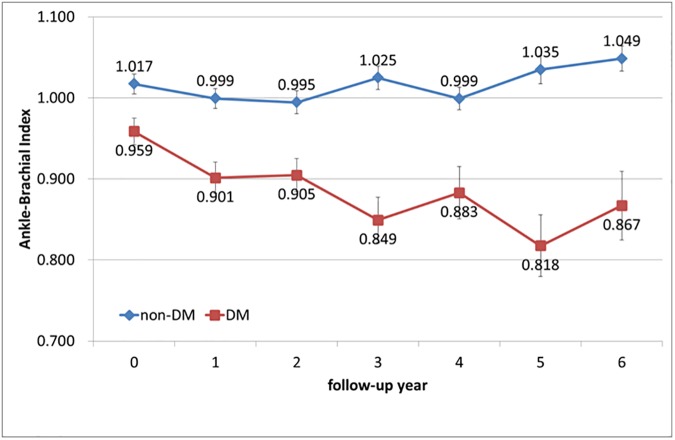
Mean Ankle-Brachial Index at each follow-up year for DM and non-DM patients (error bars indicate standard errors).